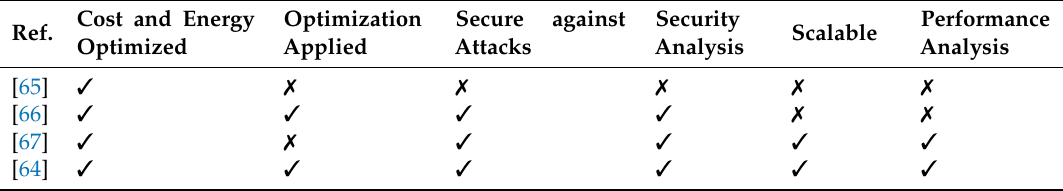
Table 4. Comparison of state-of-the-art research papers on security and privacy-preserving techniques in smart grid using blockchain.